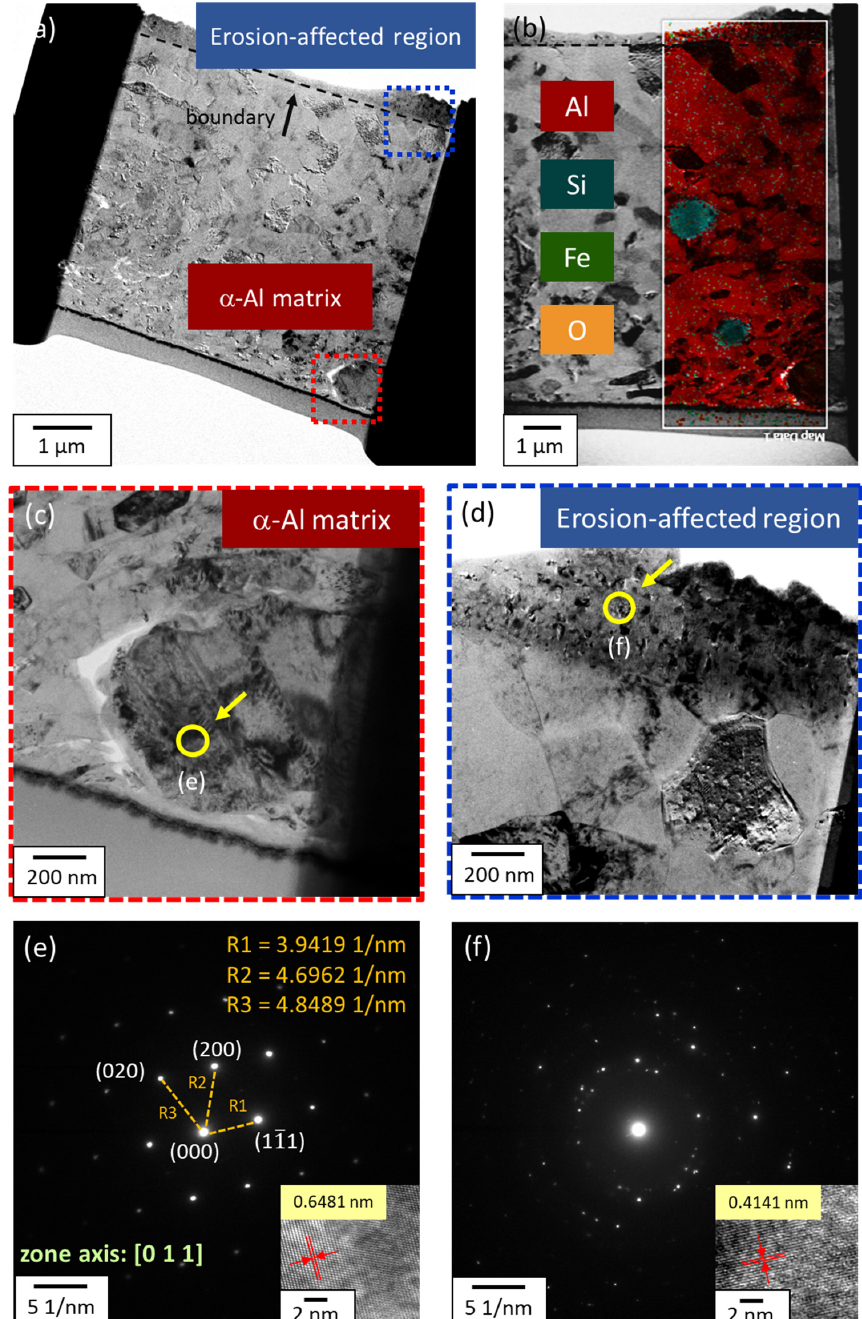
Figure 12. ( a ) TEM image of FIB cross-section view, ( b ) EDS elemental mapping images, TEM bright field image of ( c ) the α -Al matrix, ( d ) an erosion-affected region, corresponding to the SAED pattern of ( e ) the α -Al matrix, and ( f ) an erosion-affected region.